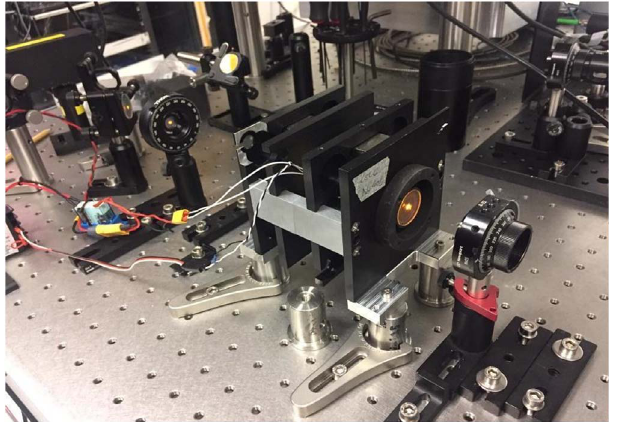
Fig. 4. One of the Na-MOF cell mounted on the optical bench at the ESO-LGS Lab.